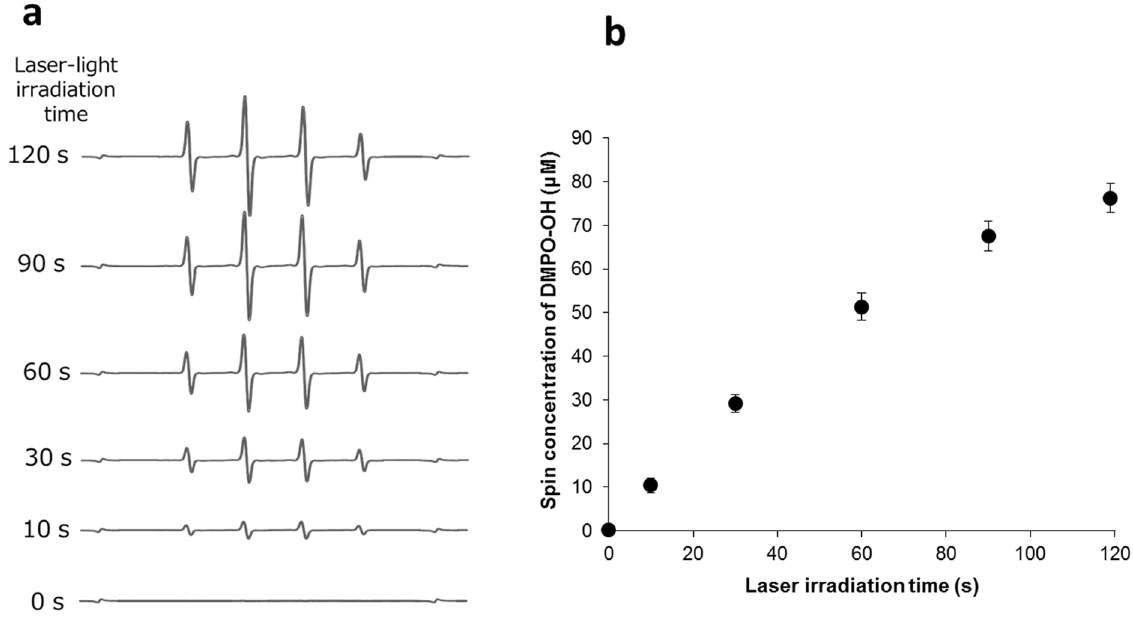
Figure 5. Representative ESR spectra and the yield of DMPO-OH obtained by laser-light irradiation of 3% H 2 O 2 . (a) ESR spectra and (b) DMPO-OH yields are shown. Each value in (b) represents the mean 6 standard deviation